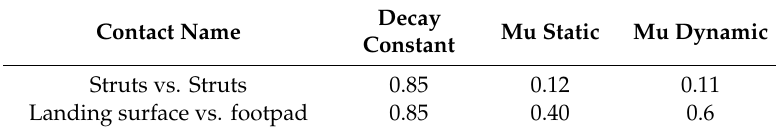
Table 7. Coulomb friction parameter defined in contacts of ML.